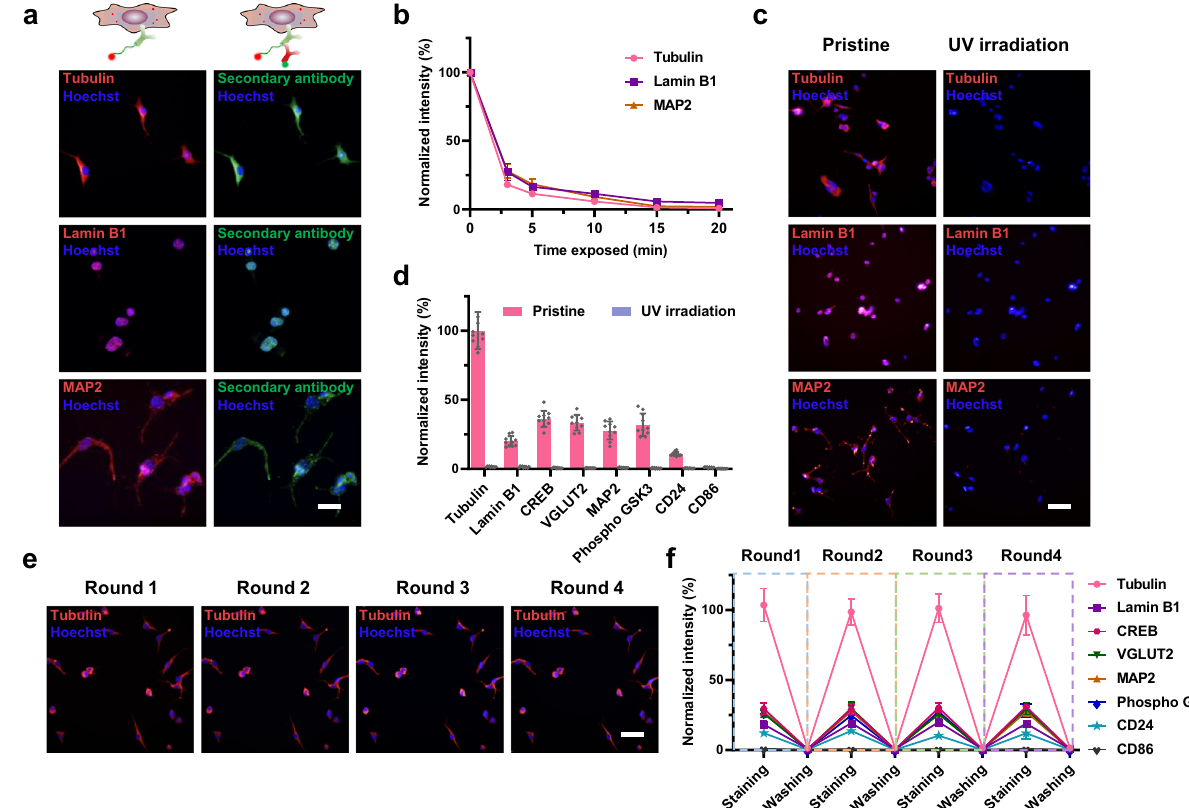
Fig. 2 Performance of multi-round conjugates labeling and complementary oligo DNAs release. a Colocalization of complementary oligo-antibody conjugates immuno fl uorescence staining labeled with Cy5 tagged-complementary oligos (left) and labeled with Alexa Fluor-488 tagged secondary antibody (right). Scale bars: 20 μ m. b Ef fi ciency of UV cleavage over time for three complementary oligo-antibody conjugates, n = 8 independent experiments on same single cells. c , d Measurement of binding location and UV cleavage ef fi ciency for eight conjugates, n = 10 independent single cells. Normalized intensity in ( d ) show ~97.4% complementary oligo being released after 15 min UV exposure. All fl uorescence intensities of conjugates staining were normalized by tubulin intensity. Scale bars: 50 μ m. e, f Reproducibility of 4 consecutive rounds of conjugates staining, releasing, and re-staining with the same complementary oligo-antibody conjugates, n = 10 independent experiments on same single cells. All fl uorescence intensities of conjugate staining were normalized by tubulin intensity. Scale bars: 50 μ m. Data are presented as mean values± SD of more than three independent experiments, and error bars are within symbol size if not